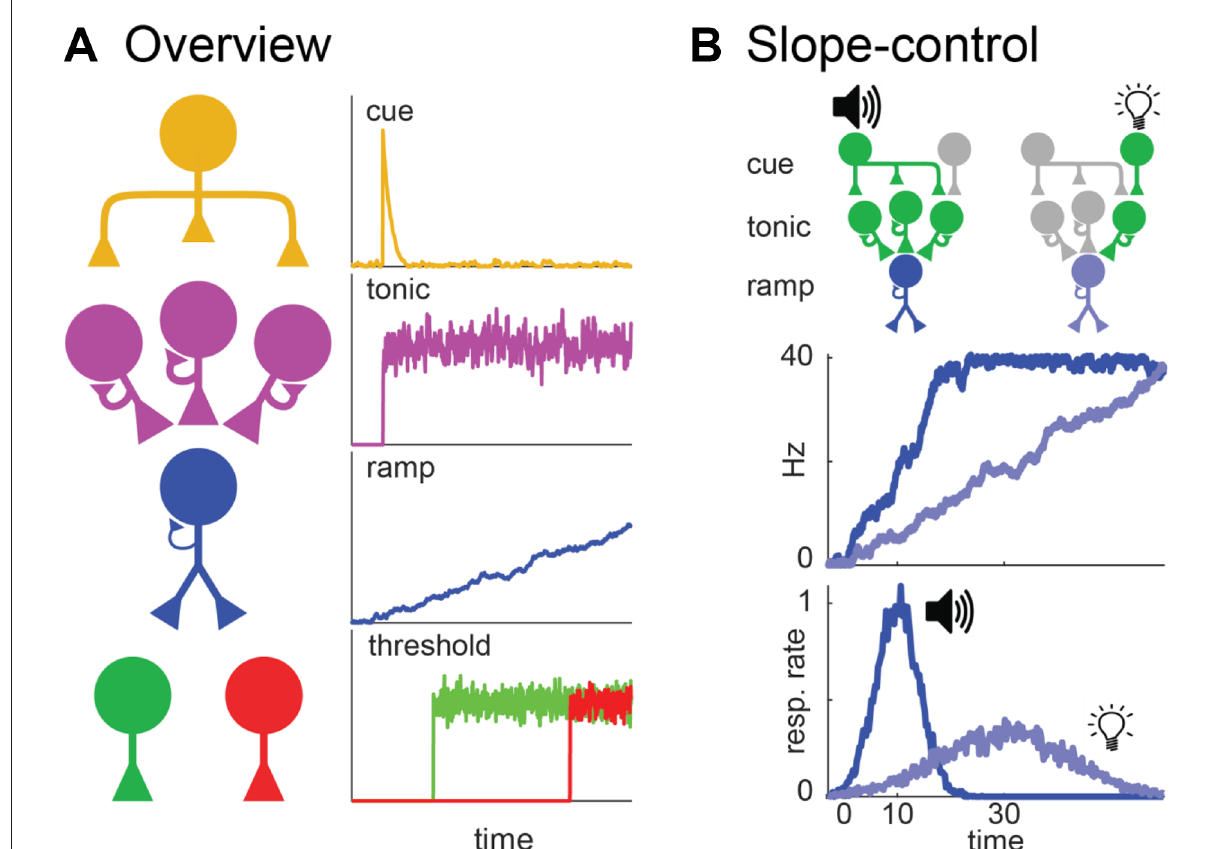
FIGURE3 Simen et al. (2011) ramping model. (A) Circuit architecture for cue, tonic, ramping, and threshold units, including purported firing profiles of each to the right according to the variant developed by De Corte (2021). (B) Slope control within the model during a task where a tone and light signal a 10 and 30 s interval, respectively. Top: Circuit-architecture for a dual-cue task as proposed by De Corte (2021). Each cue elicits a response from a different cue unit. Each unit activates the number of tonic units needed to achieve the ramp-slope for its respective interval. The middle and bottom are analogous to Figure 2 , showing simulated ramping and